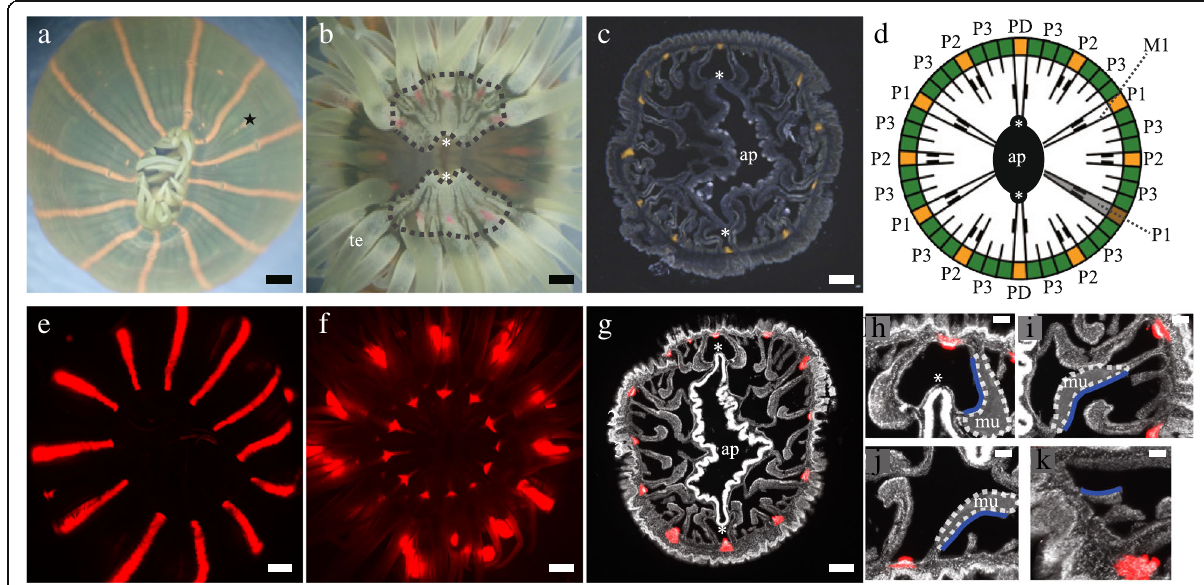
Fig. 2 Morphology and organ arrangement of D. lineata. a External view of a D. lineata polyp . Transparency of the ectodermal cell layer allows us to see black mesenteries and orange-pigmented stripes at PDs, P1s, and P2s, while orange pigmentation sporadically appears at P3s (star). Scale bar indicates 1 mm. b Longitudinal actinopharynx and siphonoglyphs located on the oral disk surrounded by tentacles. Fan-shaped white pigmentation (outlined with gray dashed lines) appears at the base of the tentacles centered around the siphonoglyph. Scale bar indicates 1 mm. te: tentacles. c Horizontal histological section demonstrating orange pigmentation at the endodermal cell layer of the PD, P1, and P2 walls. Scale bar, 200 μ m. d Schematic view of a horizontal section of a biradially symmetrical 12-striped (orange) individual. Green regions indicate P3s and pouches adjacent to P3s. Orange regions indicate P1s, P2s, and PDs. e , f External view of red fluorescence protein colocalized with orange stripes at ( e ) the root of tentacles on the oral disk ( f ). Scale bar indicates 1 mm. g Horizontal histological section demonstrating mesentery, muscle, and siphonoglyph arrangement. Nuclei are labeled with 4 ′ ,6-diamidino-2-phenylindole (white). Scale bar indicates 200 μ m. h – k Enlarged views of histological sections of G showing a ( h ) MD, ( i ) M1, ( j ) M2, and ( k ) M3 (white dotted lines indicate the outline of muscle, blue lines indicate the mesenteries). Scale bars, 50 μ m. ap: actinopharynx, mu: muscles, M1: first mesentery. PD, P1, P2, and P3 denote directive, first, second, and third gastric pouches, respectively. Asterisks indicate